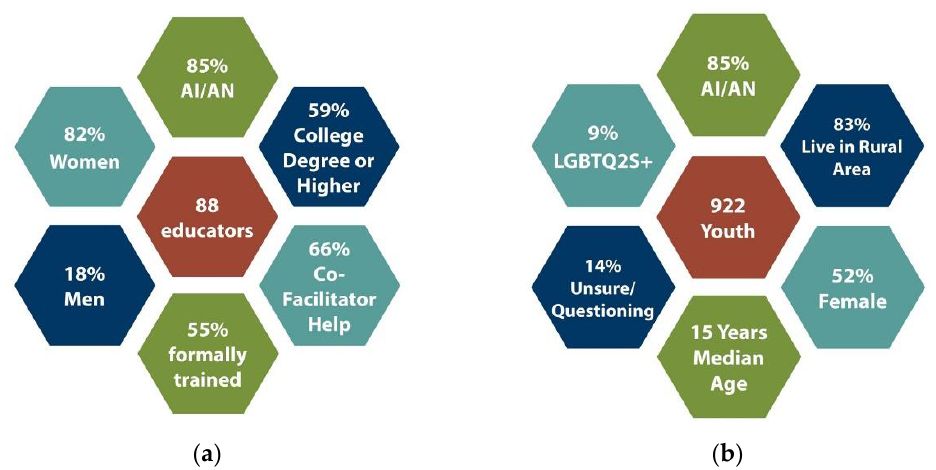
Figure 1. Profiles of Native STAND educators ( a ) and youth participants ( b ), 2015–2019.